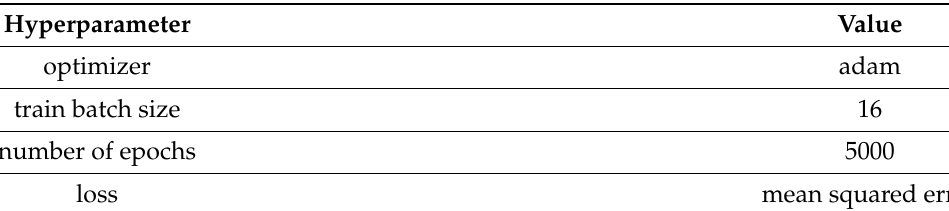
Table 5. Hyperparameters used for the